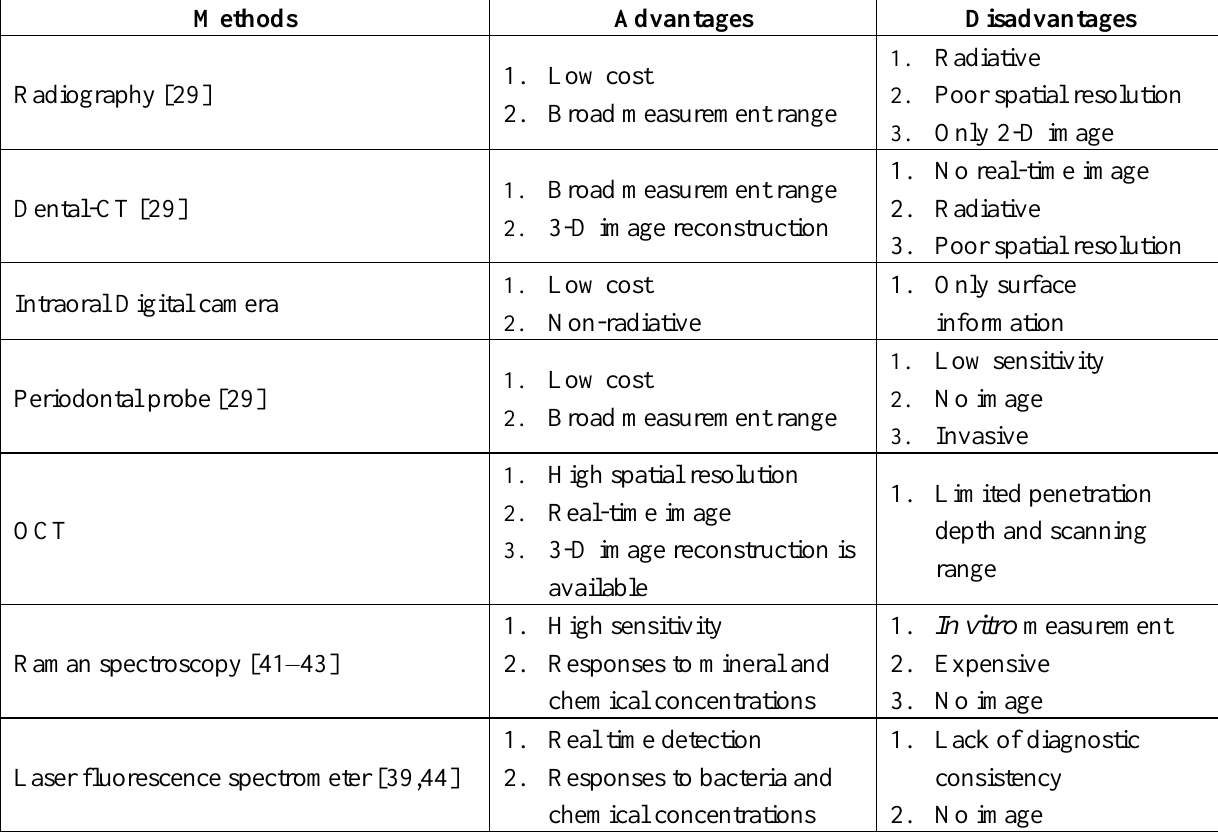
Table 1. Comparison between dental OCT and other